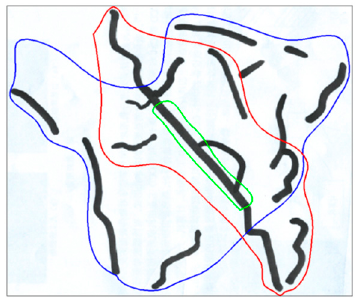
Figure 12. Schematic diagram of sandstone specimen fracture.